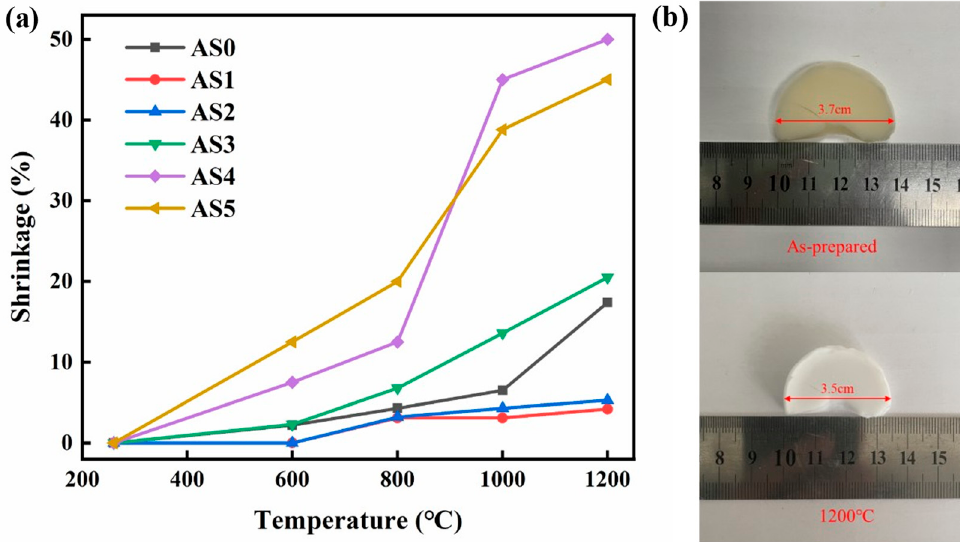
Figure 2. ( a ) The linear shrinkage of AS samples after heat treatment; ( b ) digital photos of AS1 before and after 1200 °C heat treatment.